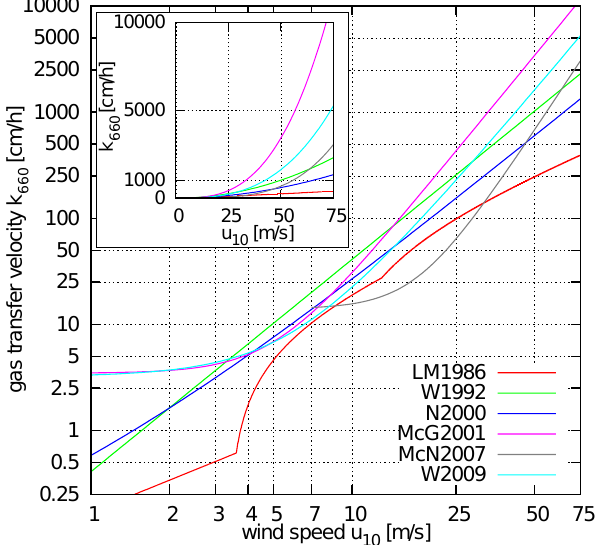
Fig. 1. Some commonly used gas-transfer–wind-speed parameter- izations in a double logarithmic plot. The insert shows the same, but with linear axes. LM1986: Liss and Merlivat (1986), W1992: Wanninkhof (1992), N2000: Nightingale et al. (2000), McG2001: McGillis et al. (2001) and W2009: Wanninkhof et al. (2009). The parameterization by McNeil and D’Asaro (2007) (McN2007) is the only one developed for hurricane wind